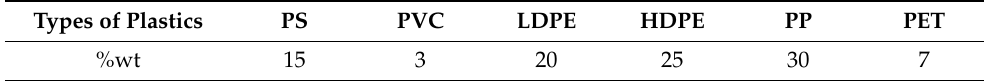
Table 1. Plasmix